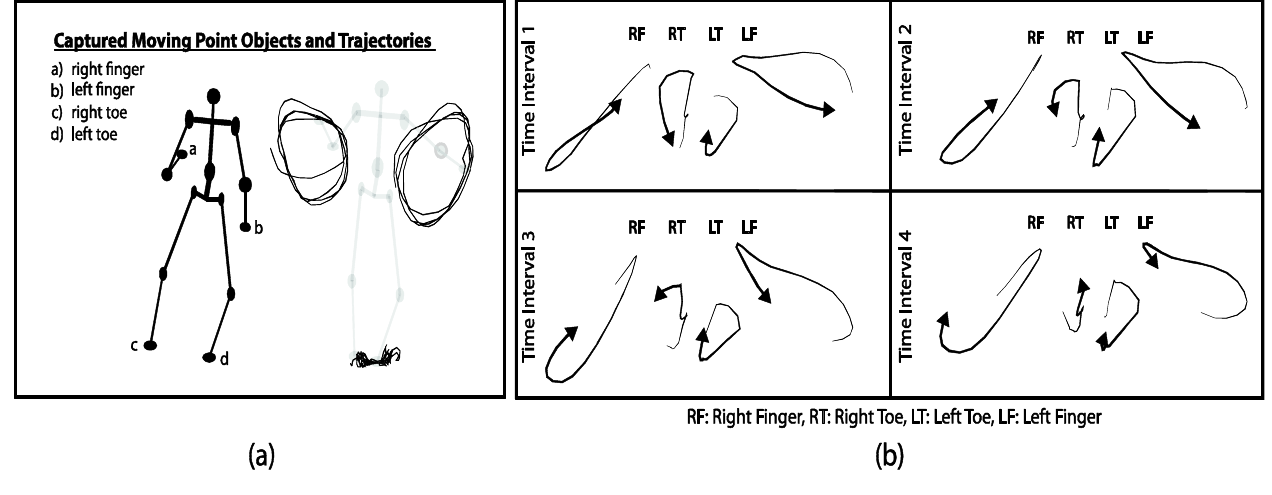
Figure 10. ( a ) An abstracted movement of a samba dancer based on four parts of the body (right finger, left finger, right toe, and left toe), and ( b ) top view of movements of the samba dancer during four different time intervals, each lasting 0.8